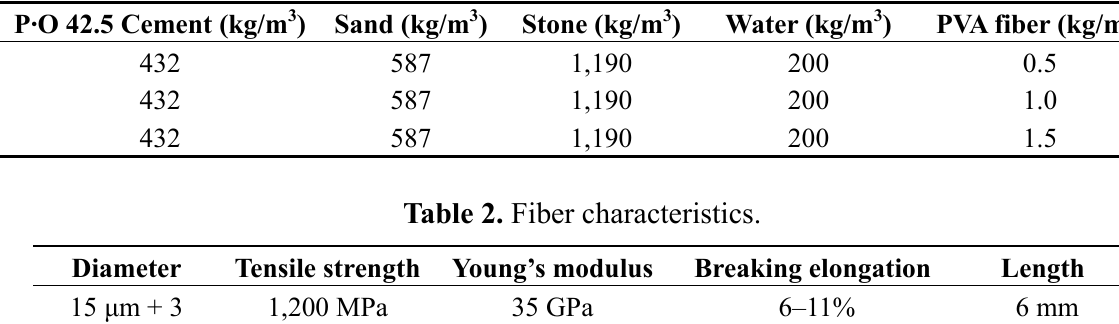
Table 1. Concrete mixture ratio.